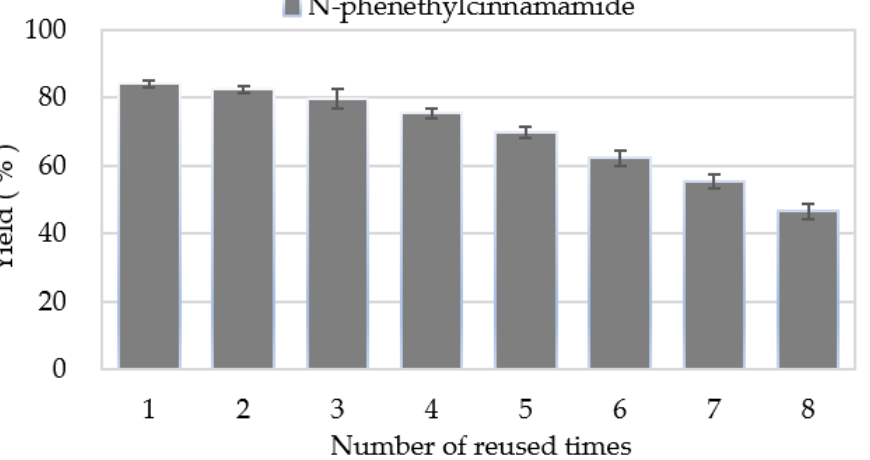
Figure 5. The effect of reused times on the synthesis of N-phenethylcinnamamide catalyzed by Lipozyme ® TL IM in continuous-flow microreactors.